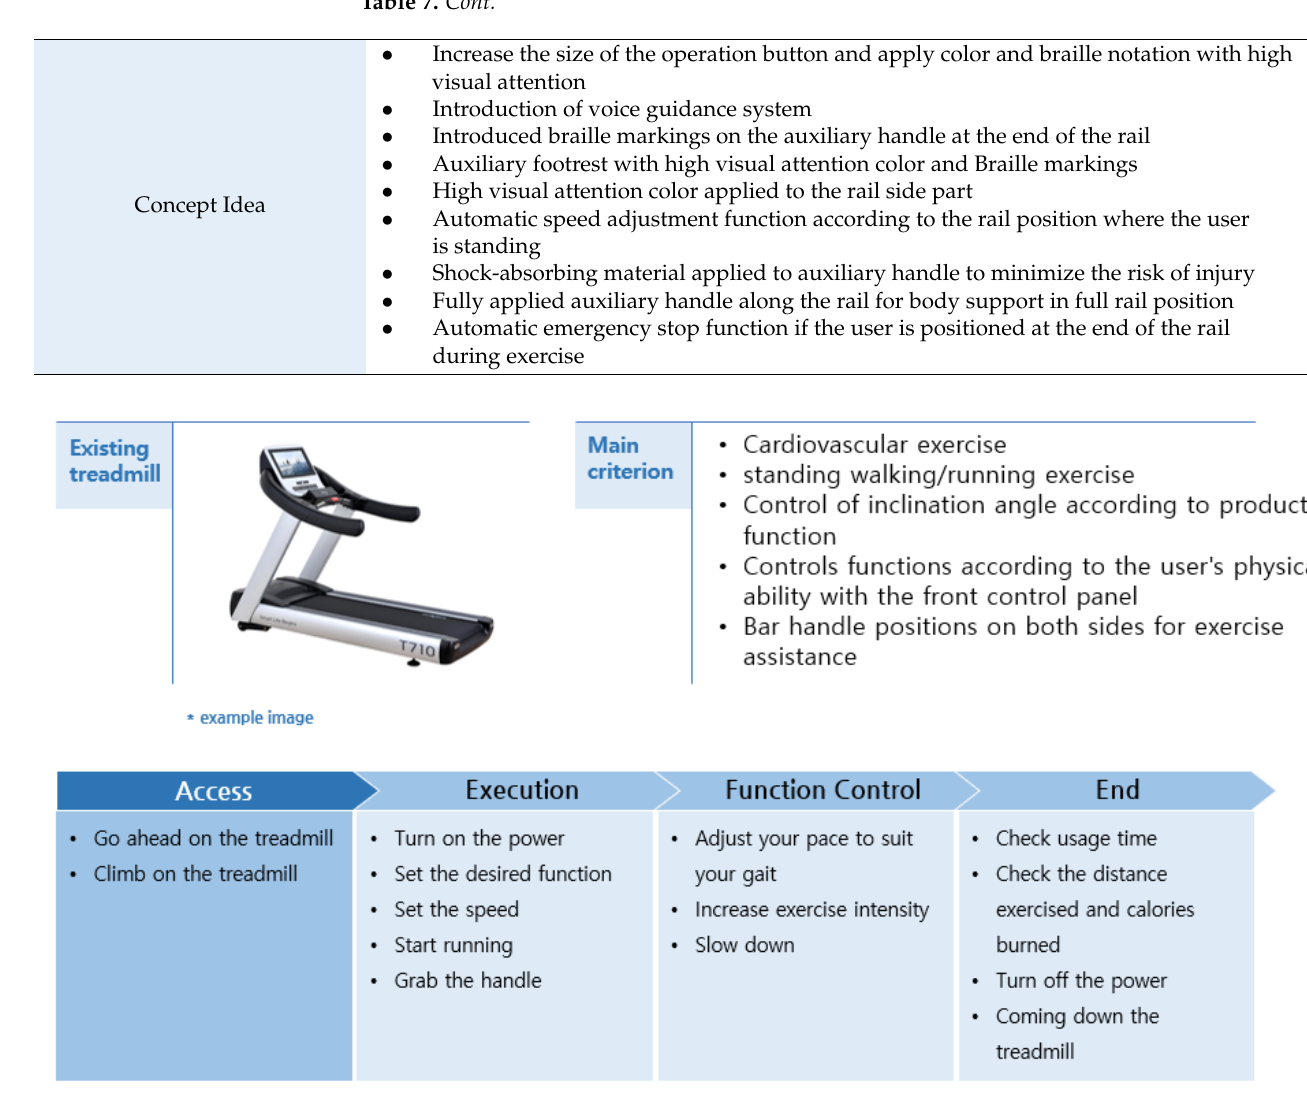
Figure 3. Treadmill concept idea. Table 7. Problems of existing treadmills and concept ideas applying universal design.